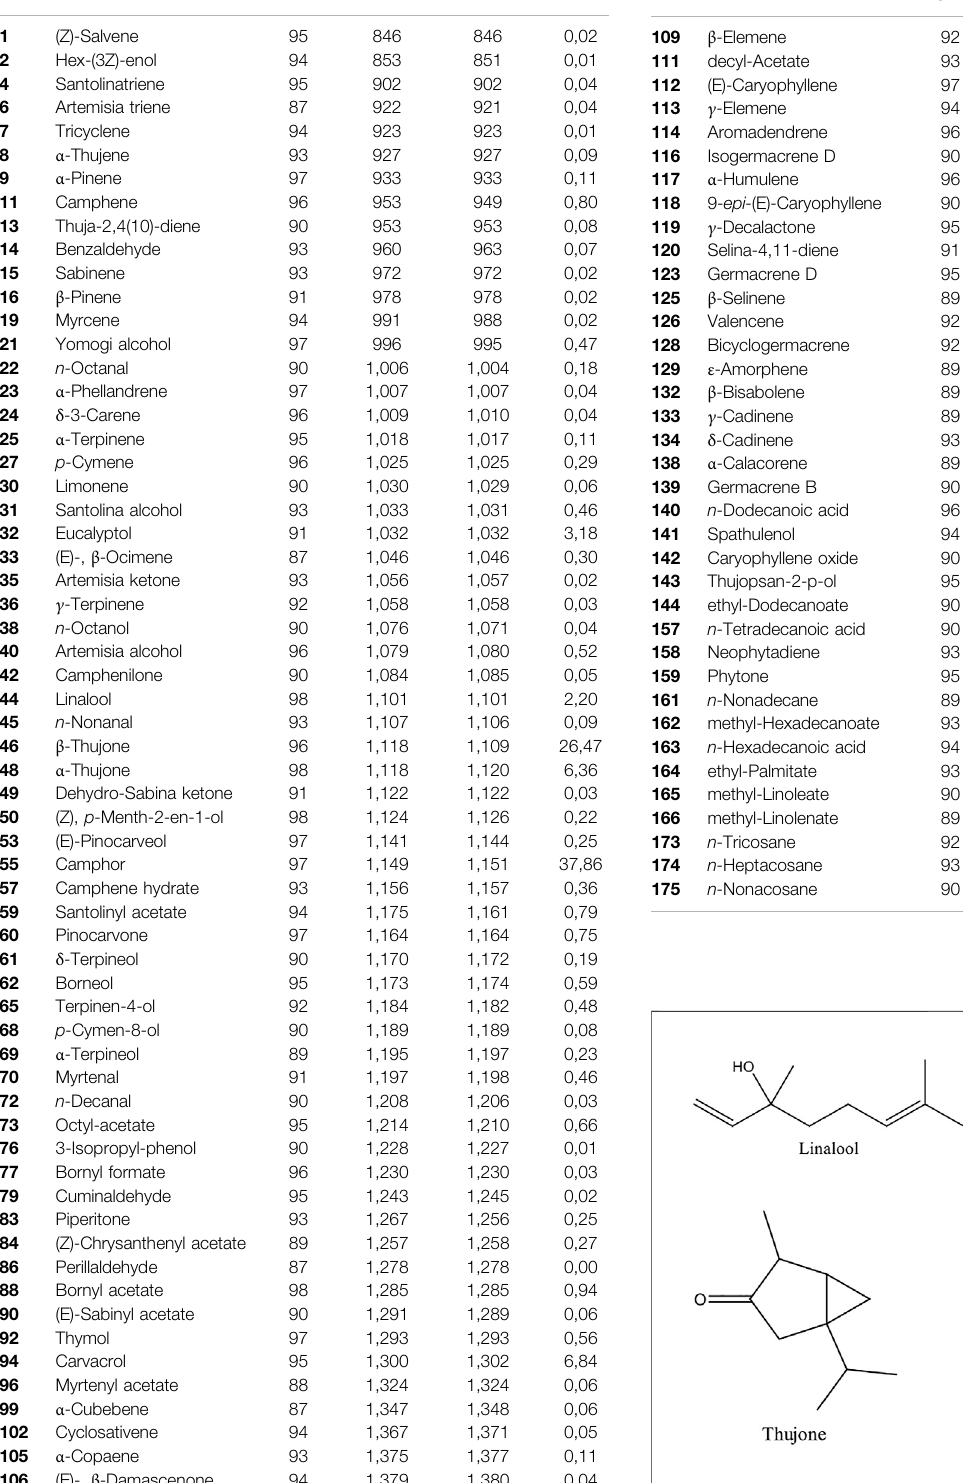
FIGURE 2 | Molecular structure of the main compounds identi fi ed in the